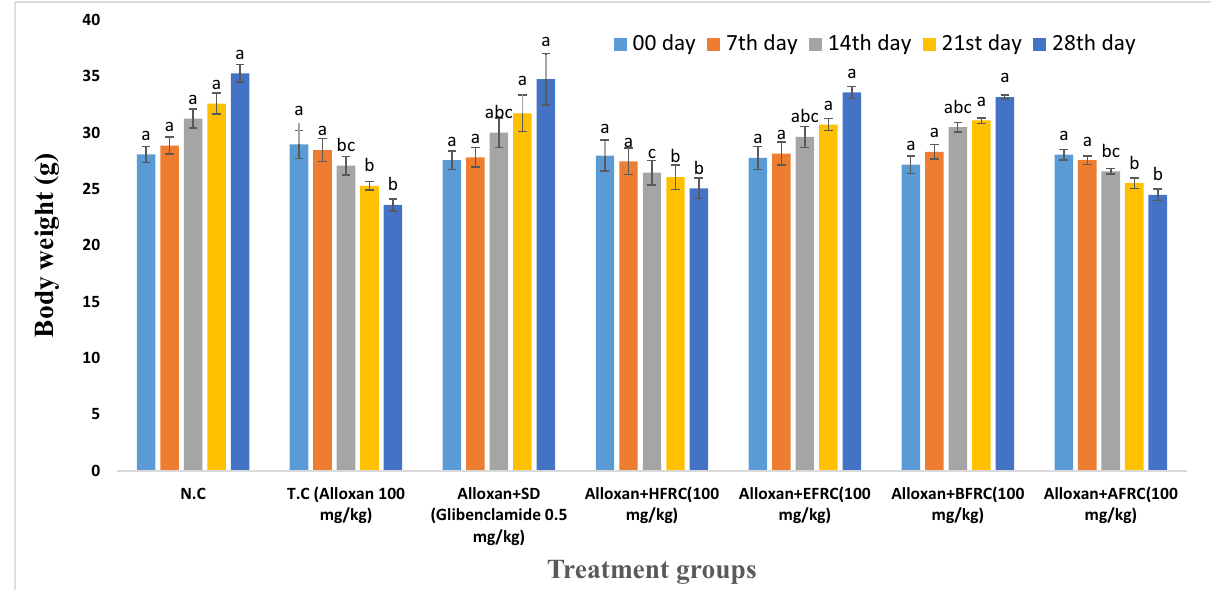
Figure 2: E ff ect of di ff erent fractions of R. cordifolia on body weight ( BW ) of alloxan - induced diabetic mice. Values are expressed as mean ± S.E ( n = 5 ) letters a, b, c … show the signi fi cant ( P < 0.05 ) di ff erence and same letters show nonsigni fi cant ( P > 0.05 ) di ff